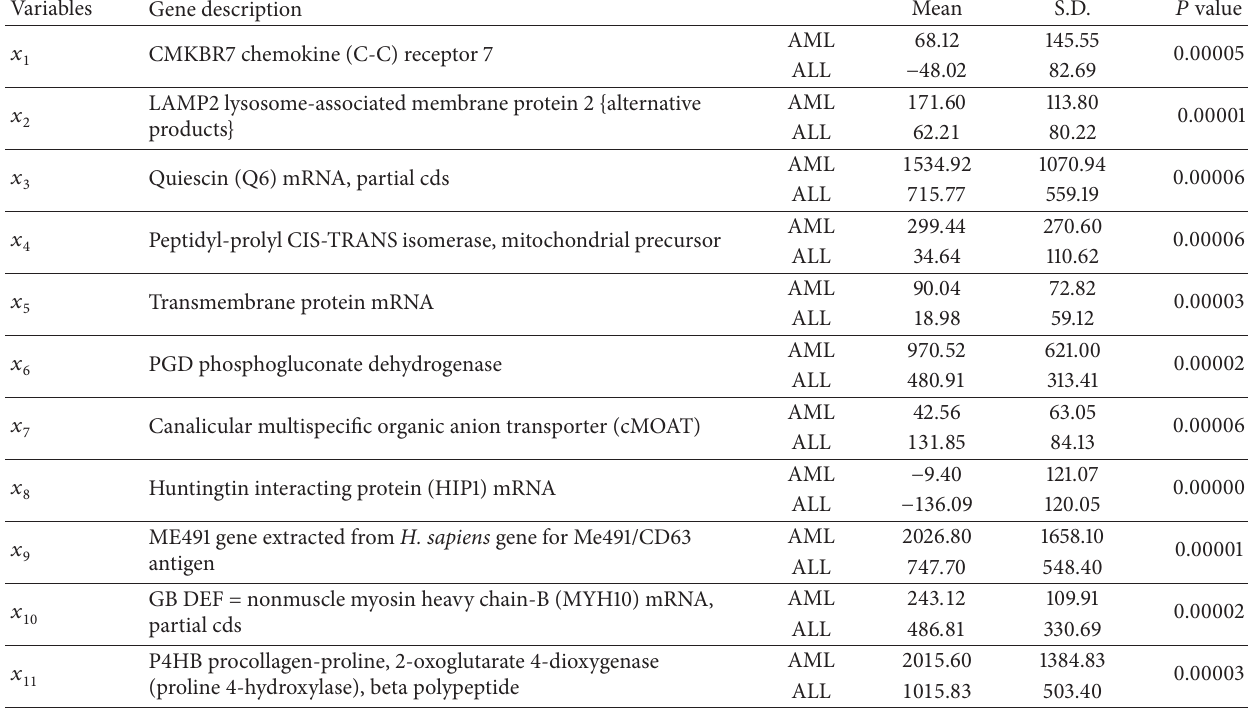
Table 1: The influencing genes selected by using two-sample 𝑡 -test with a significance level of 0.0001.